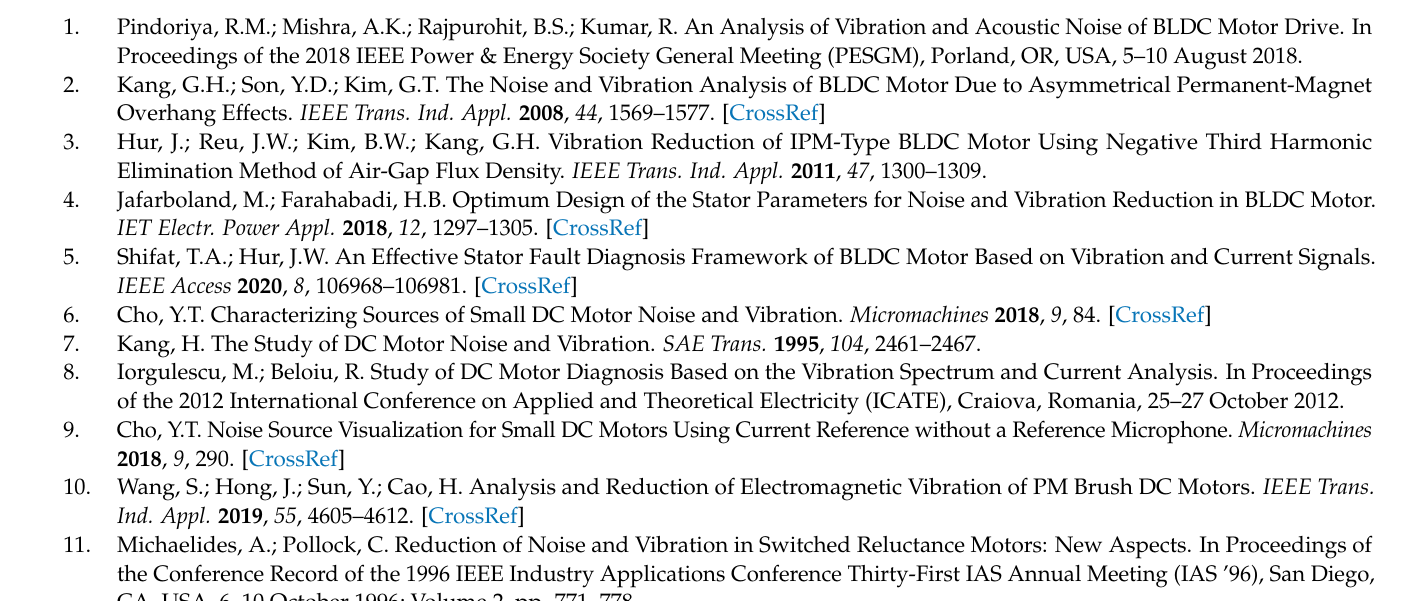
Figure A1. Classic block diagram of brushed DC motor.